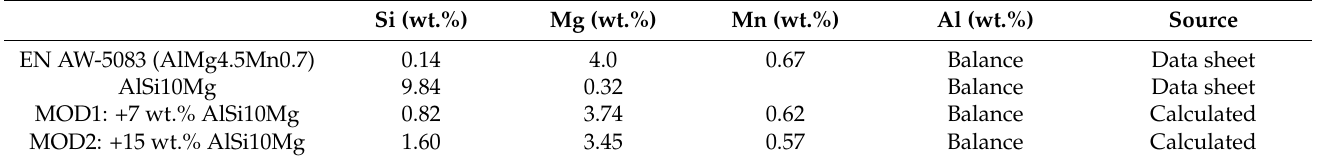
Table 3. Alloy composition of the base alloy, supplement AlSi10Mg powder, and two modifications. Si (wt.%)